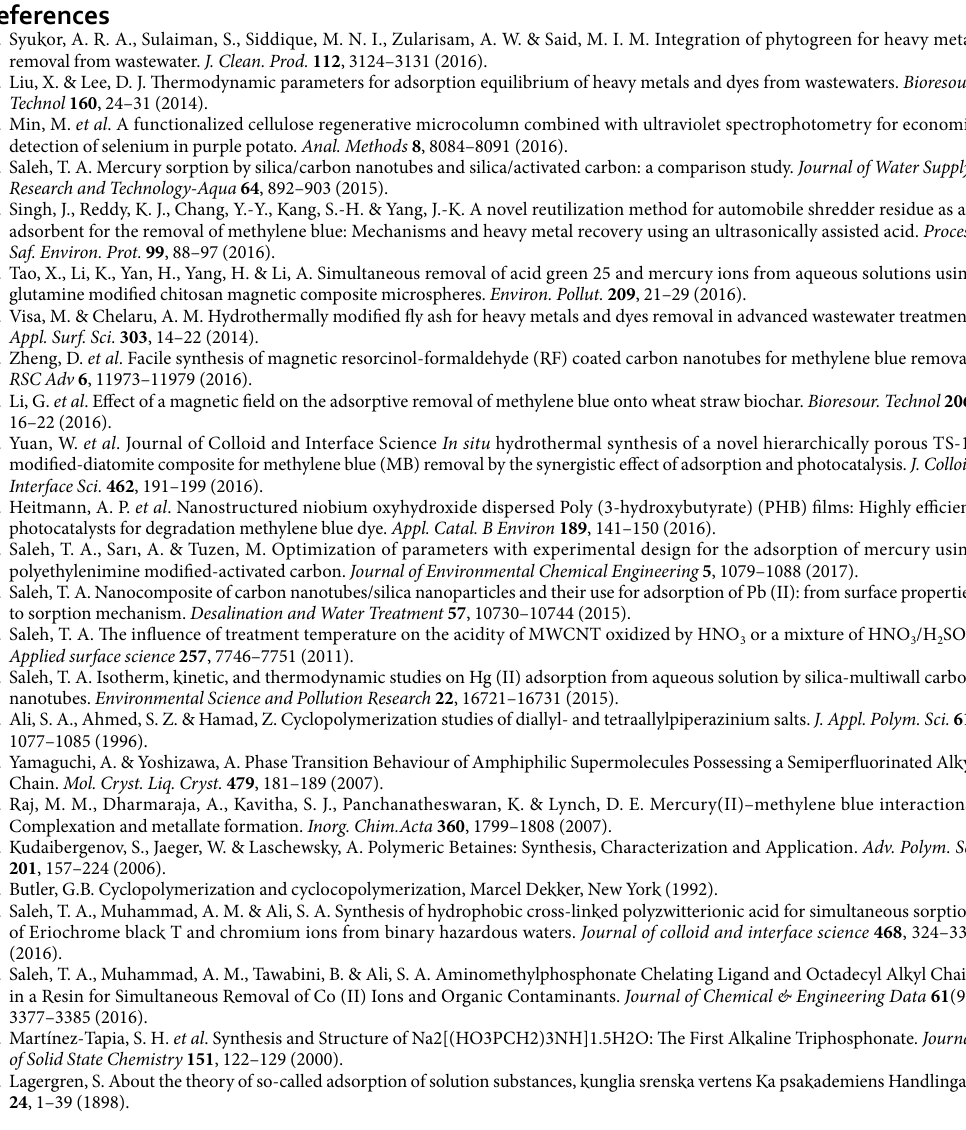
via the second-order kinetic mechanism with an R 2 value of > 0.99 for all of the studied concentrations. The initial concentration, temperature, and pH, as well as the surface-active sites, all contribute to the adsorption efficiency. The regeneration tests were achieved by using 0.1 M HCl for Hg(II) and acetone for methylene blue. In addition to being cost-effective, the resin has advantageous properties such as active sites, high adsorption capacity, high reusability, and ease-of-use, in addition to being cost-effective. The polymer has demonstrated remarkable effi- ciency in the simultaneous removal of toxic Hg(II) ions and methylene blue from aqueous systems.